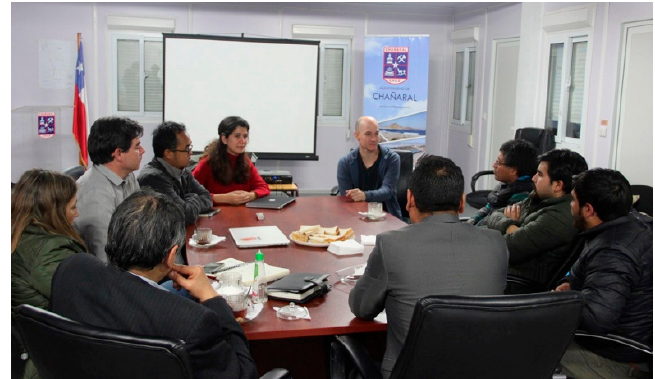
Figure 7. Key informant interviews with planning officers and other civil servants.